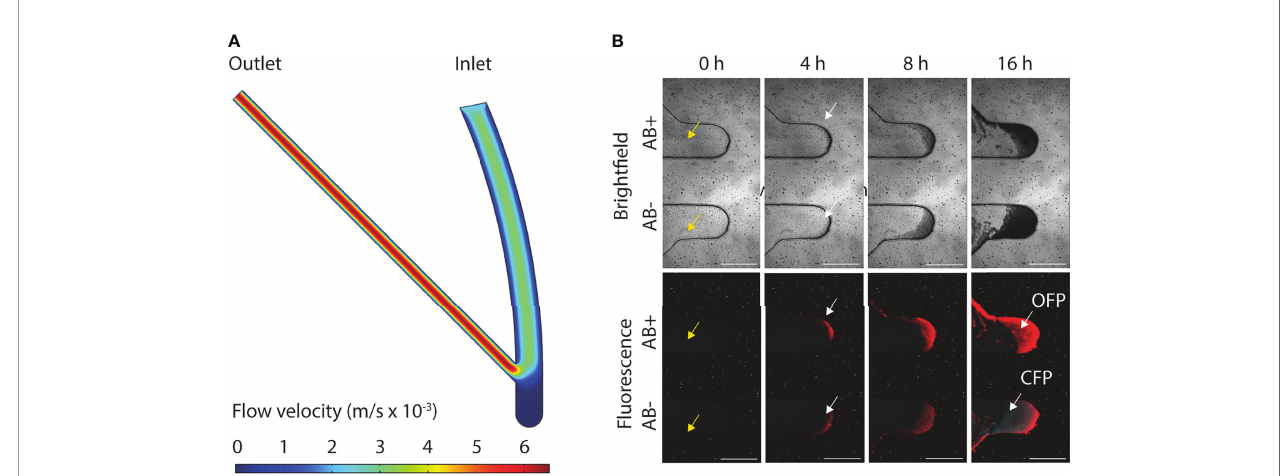
FIGURE 2 | Overview of fl ow dynamics and formation of E. coli MG1655 bio fi lms. (A) FEM simulation of the fl ow velocities (m/s × 10 -3 ) in the fl ow channels and growth chamber of the bio fi lm chip. (B) Representative confocal images of mixed strain bio fi lm development with (AB+) or without (AB-) cipro fl oxacin treatment at inhibitory concertation (0.16 mg/L). CFP (cyan fl uorescent protein) and OFP (orange fl uorescent protein) tagged E. coli MG1655 both susceptible to cipro fl oxacin were cultivated in the bottom growth chamber in the micro fl uidic chip. OFP tagged E. coli MG1655 resistant to cipro fl oxacin and CFP tagged E. coli MG1655 susceptible to cipro fl oxacin were cultivated in the top growth chamber in the micro fl uidic chip. Yellow arrows indicate absence of cells within the inlet and outlet channels after bio fi lm seeding. White arrows indicate initial bio fi lm formation at 4 h post-seeding. All scale bars represent 500